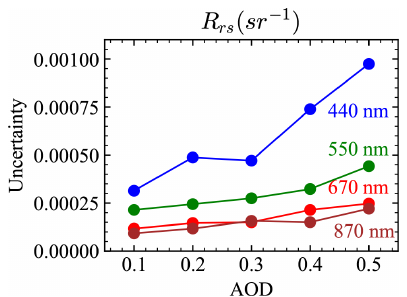
Figure 11. Retrieval uncertainties for R rs at the four AirHARP bands. The uncertainties are computed in the same way as for Fig. 9 in terms of